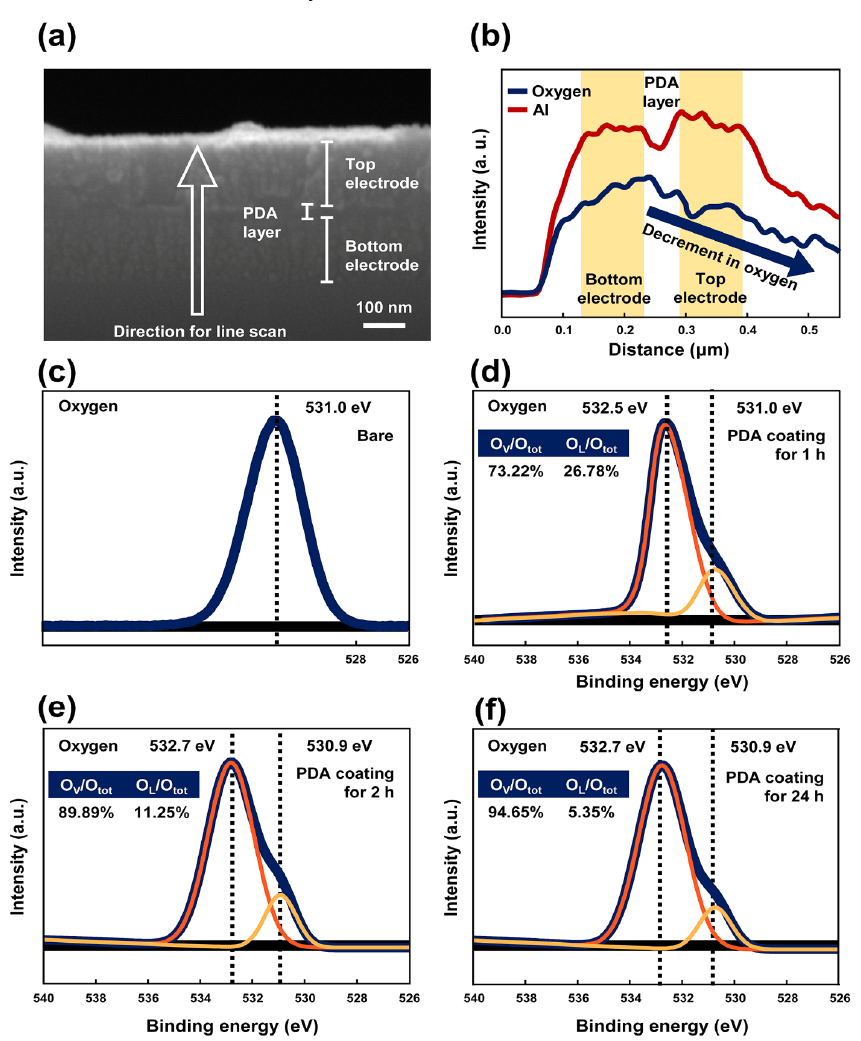
Figure 4. The ( a ) cross section image of Al/PDA/Al structure and ( b ) its line scan result for Al and oxygen investigated by energy dispersive X-ray spectroscopy (EDS). XPS spectra of the ( c ) O 1s in a bare Al electrode and the PDA/Al structure coated with a PDA layer coated for ( d ) 1 h, ( e ) 2 h, and ( f ) 24 h.